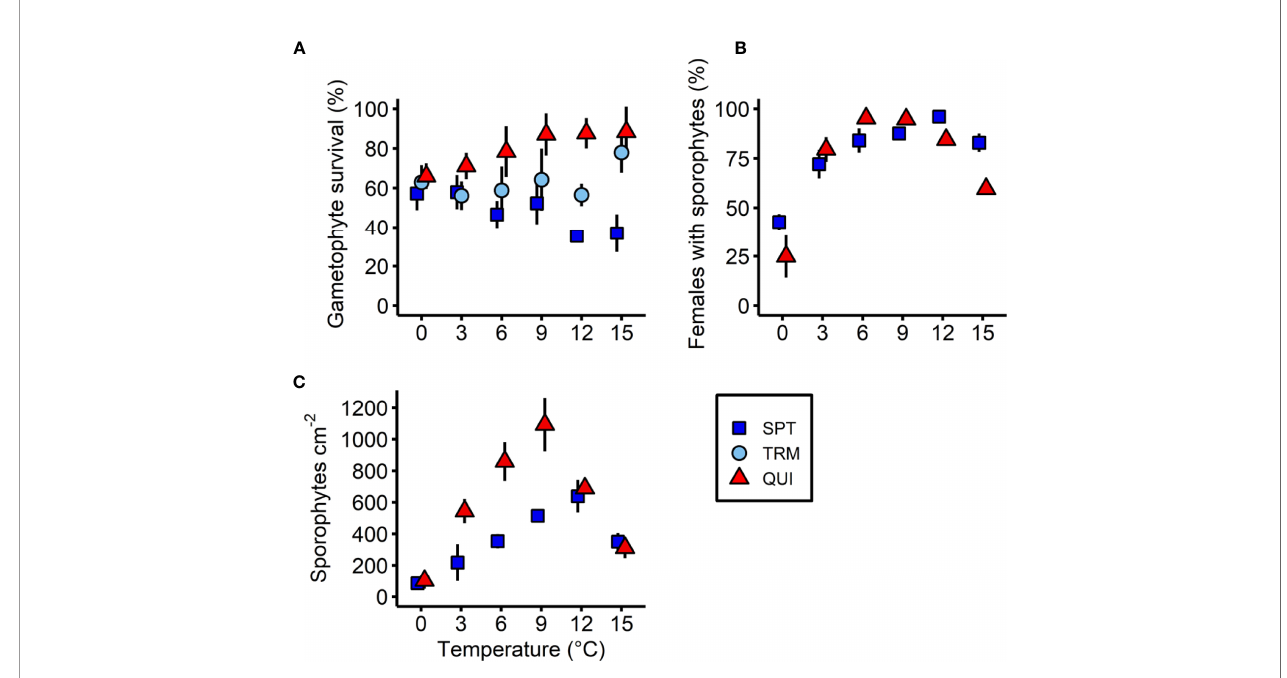
FIGURE 5 | Effect of temperature on (A) the gametophyte survival (%), (B) females with microscopic sporophytes (%) and (C) absolute sporophyte density of Laminaria digitata on day 21 in three populations (Spitsbergen, SPT; Tromsø, TRM; Quiberon, QUI) along a temperature gradient between 0°C and 15°C during experiment 2. The Tromsø population was excluded in (B) and (C) , due to high egg mortality after 14 days. Values are expressed as the mean ± SD (n = 5).